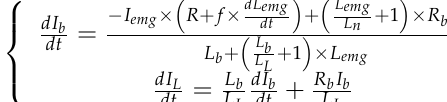
Figure 4. Experimental and calculated (dashed) dependence of the resistance of the circuit breaker from time to time.